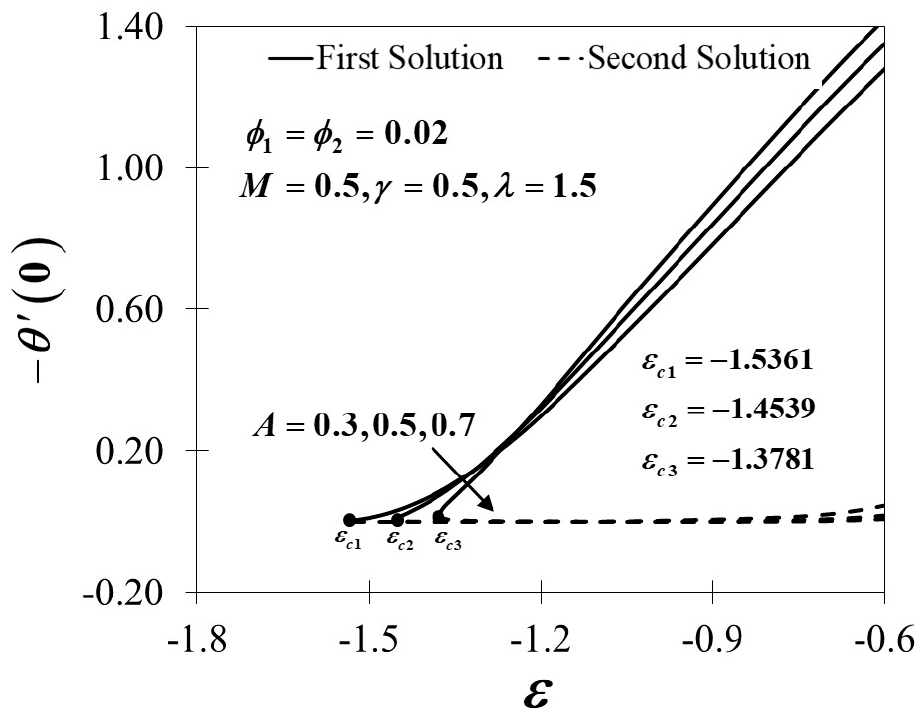
Figure 17. Variations of g ′′ (0) for different values of A .